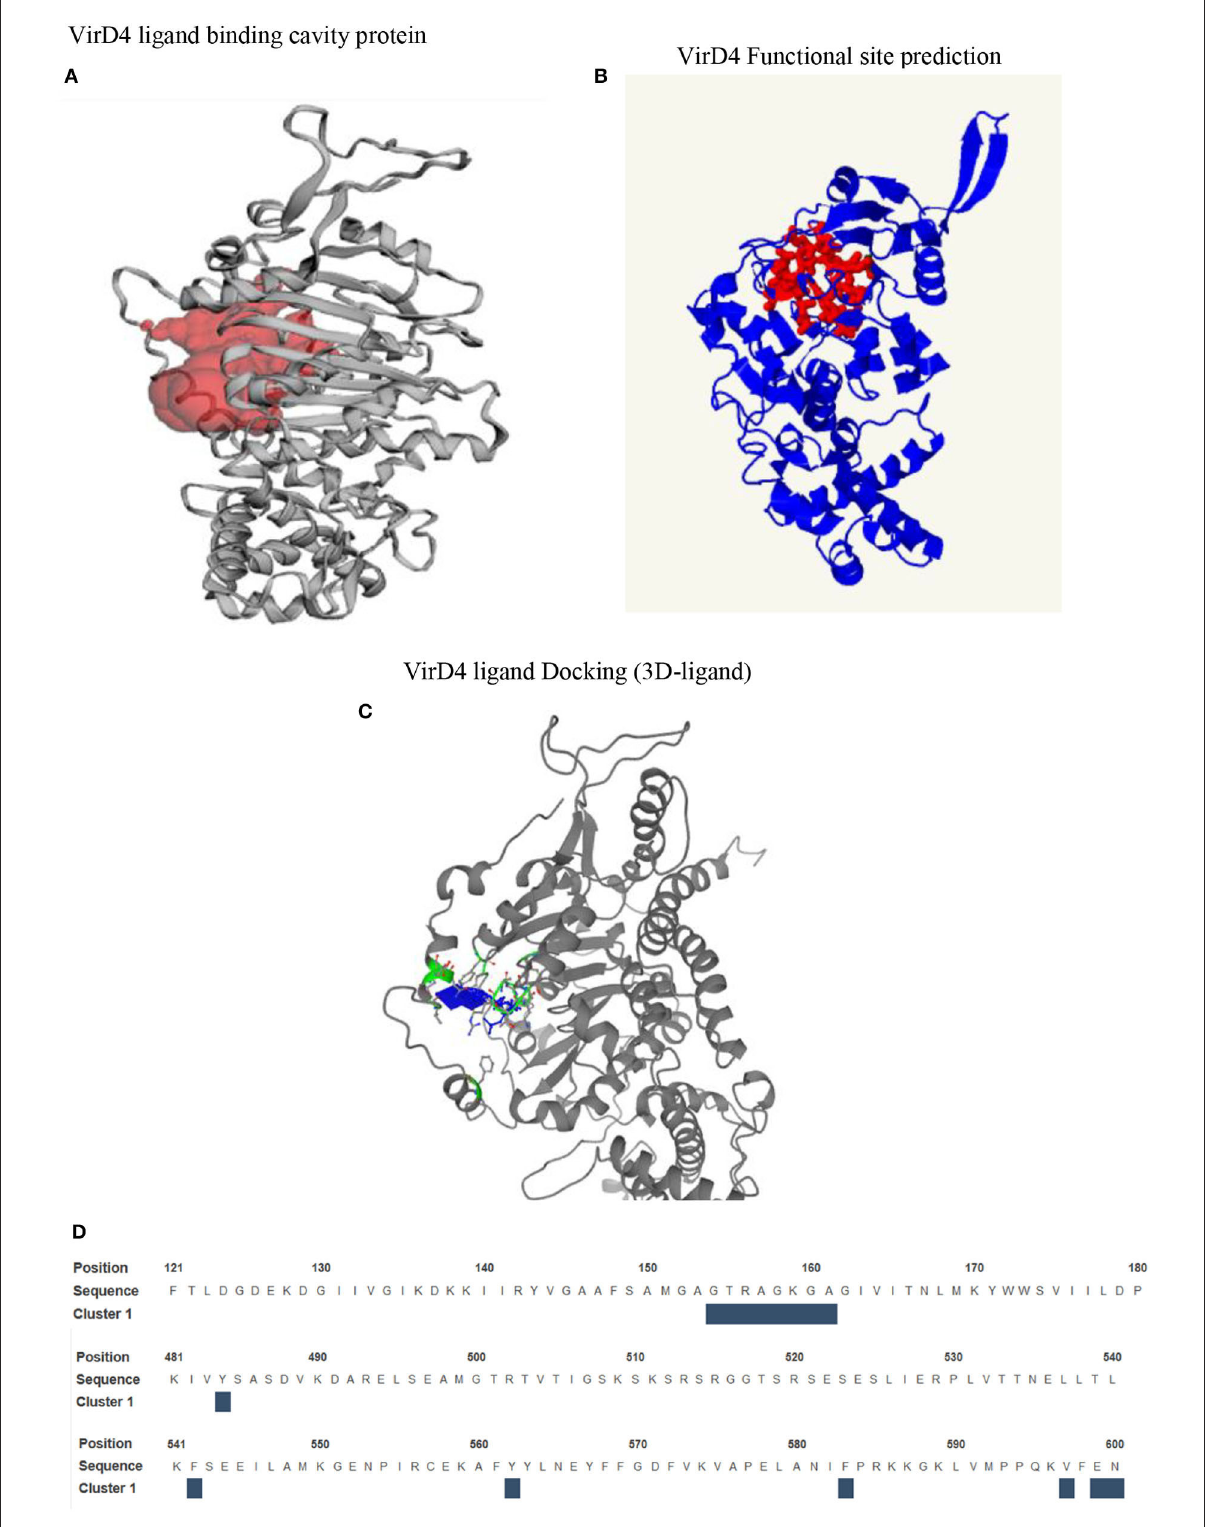
FIGURE3 (A) Surface topology predicts the cavity on VirD4 structure. In this figure, we have shown the well-defined cavity that occupies the N-terminal region between the β -strands and is surrounded by α -helices. (B) The prediction of functional residues that are likely involved in substrate binding. (C) The nucleotide-binding region is shown in blue, which is surrounded by Walker A and B motifs, shown in green with stick representation. (D) This sequence shows the location of Walker A and B motifs. The interacting residues are shown above the blue